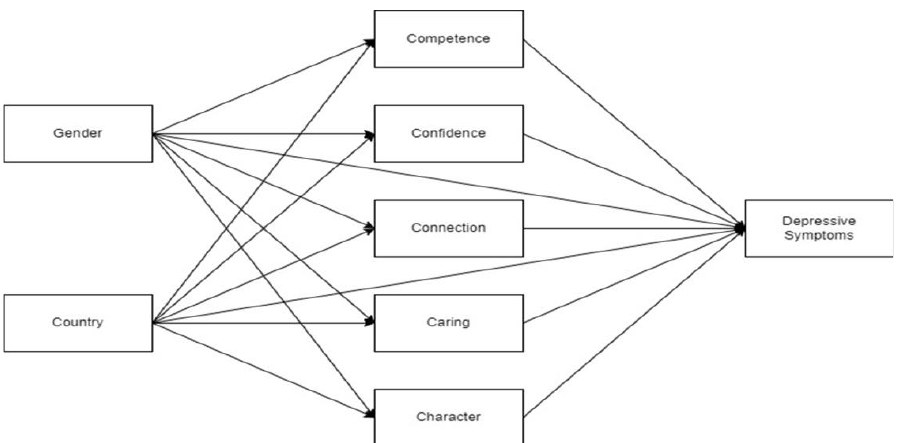
Figure 1. Proposed Multiple partial mediation model of the effects of gender and country on depressive symptoms through the 5Cs of PYD.